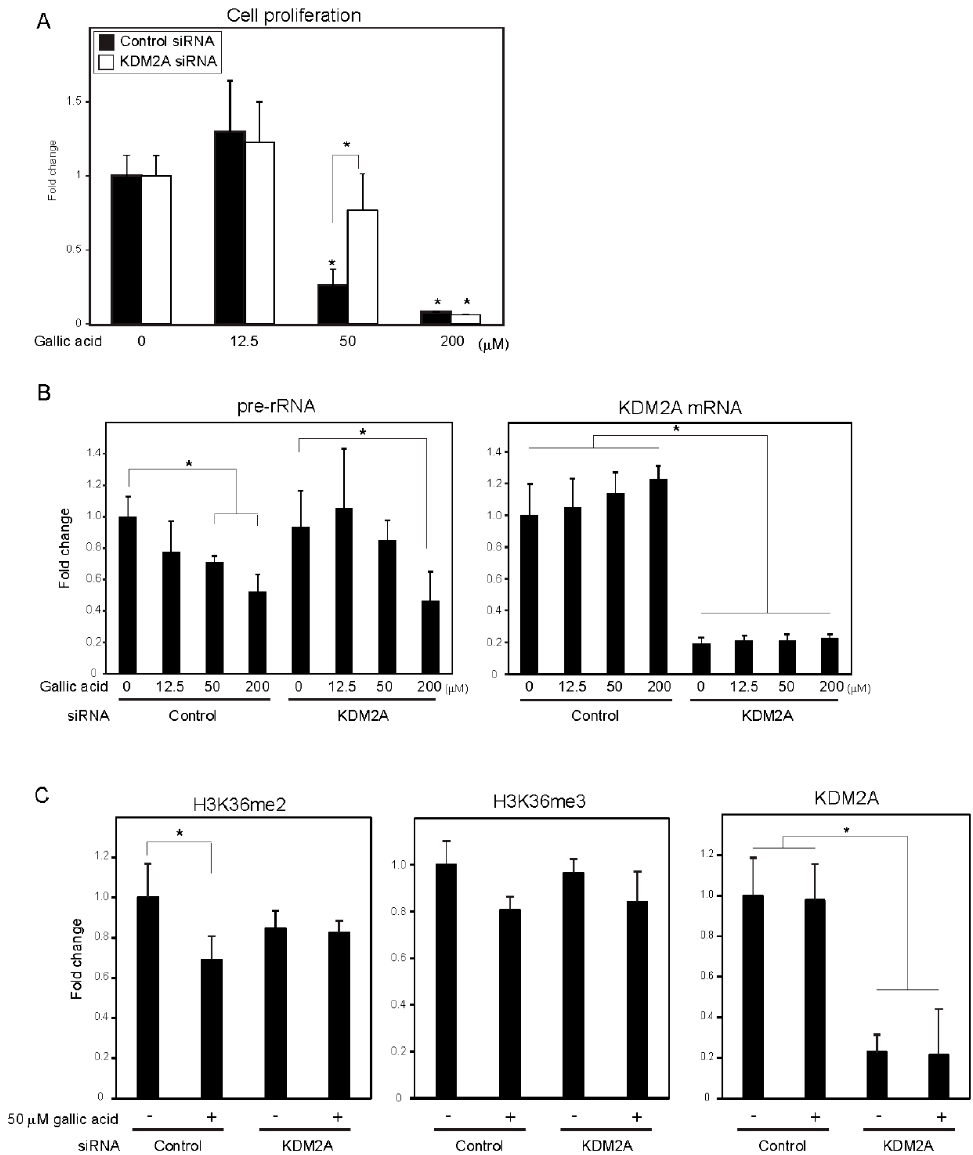
Figure 1. Gallic acid induced KDM2A-dependent reductions of cell proliferation, rRNA transcription, and H3K36me2 in rDNA promoter in MCF-7 cells. ( A ) Gallic acid decreased proliferation of MCF-7 cells through KDM2A. MCF-7 cells transfected with control siRNA or siRNA for KDM2A were cultured with gallic acid as indicated concentrations for 2 days. Cell numbers were measured by CyQUANT ® Direct Cell Proliferation Assay detecting DNA content. ( B ) The treatment with 50 µ M gallic acid reduces rRNA transcription through KDM2A. MCF-7 cells transfected with control siRNA or siRNA for KDM2A were treated with gallic acid at indicated concentrations for 4 h. Total RNAs were isolated and analyzed by quantitative real-time PCR (qRT-PCR) to detect rRNA transcription (pre-rRNA) (left panel) and KDM2A mRNA (right panel). The ratios of the values for cells treated with various conditions to those for cells treated with control siRNA without gallic acid are shown. ( C ) KDM2A-dependent reduction of H3K36me2 marks in rDNA promoter by treatment with 50 µ M gallic acid. MCF-7 cells transfected with control siRNA or siRNA for KDM2A were treated with 50 µ M gallic acid for 4 h. The levels of H3K36me2, H3K36me3, and KDM2A in the rDNA promoter were analyzed by ChIP assay. The results are expressed as fold changes of the values under various conditions to those in cells cultured with control siRNA without gallic acid treatment. All experiments were performed more than three times, and the mean values with standard deviations are indicated. * p < 0.05.